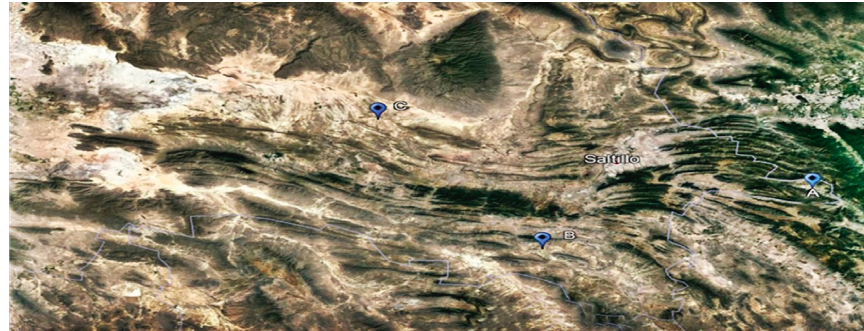
Figure 2: Sampling locations of seeds under study. (a) N. cespitifera at Ejido Nuncio, Arteaga, Coahuila; (b) A. lechuguilla at Punta Santa Elena, Saltillo, Coahuila; (c) L. graveolens at Ejido Piedra Blanca, Parras de la Fuente,